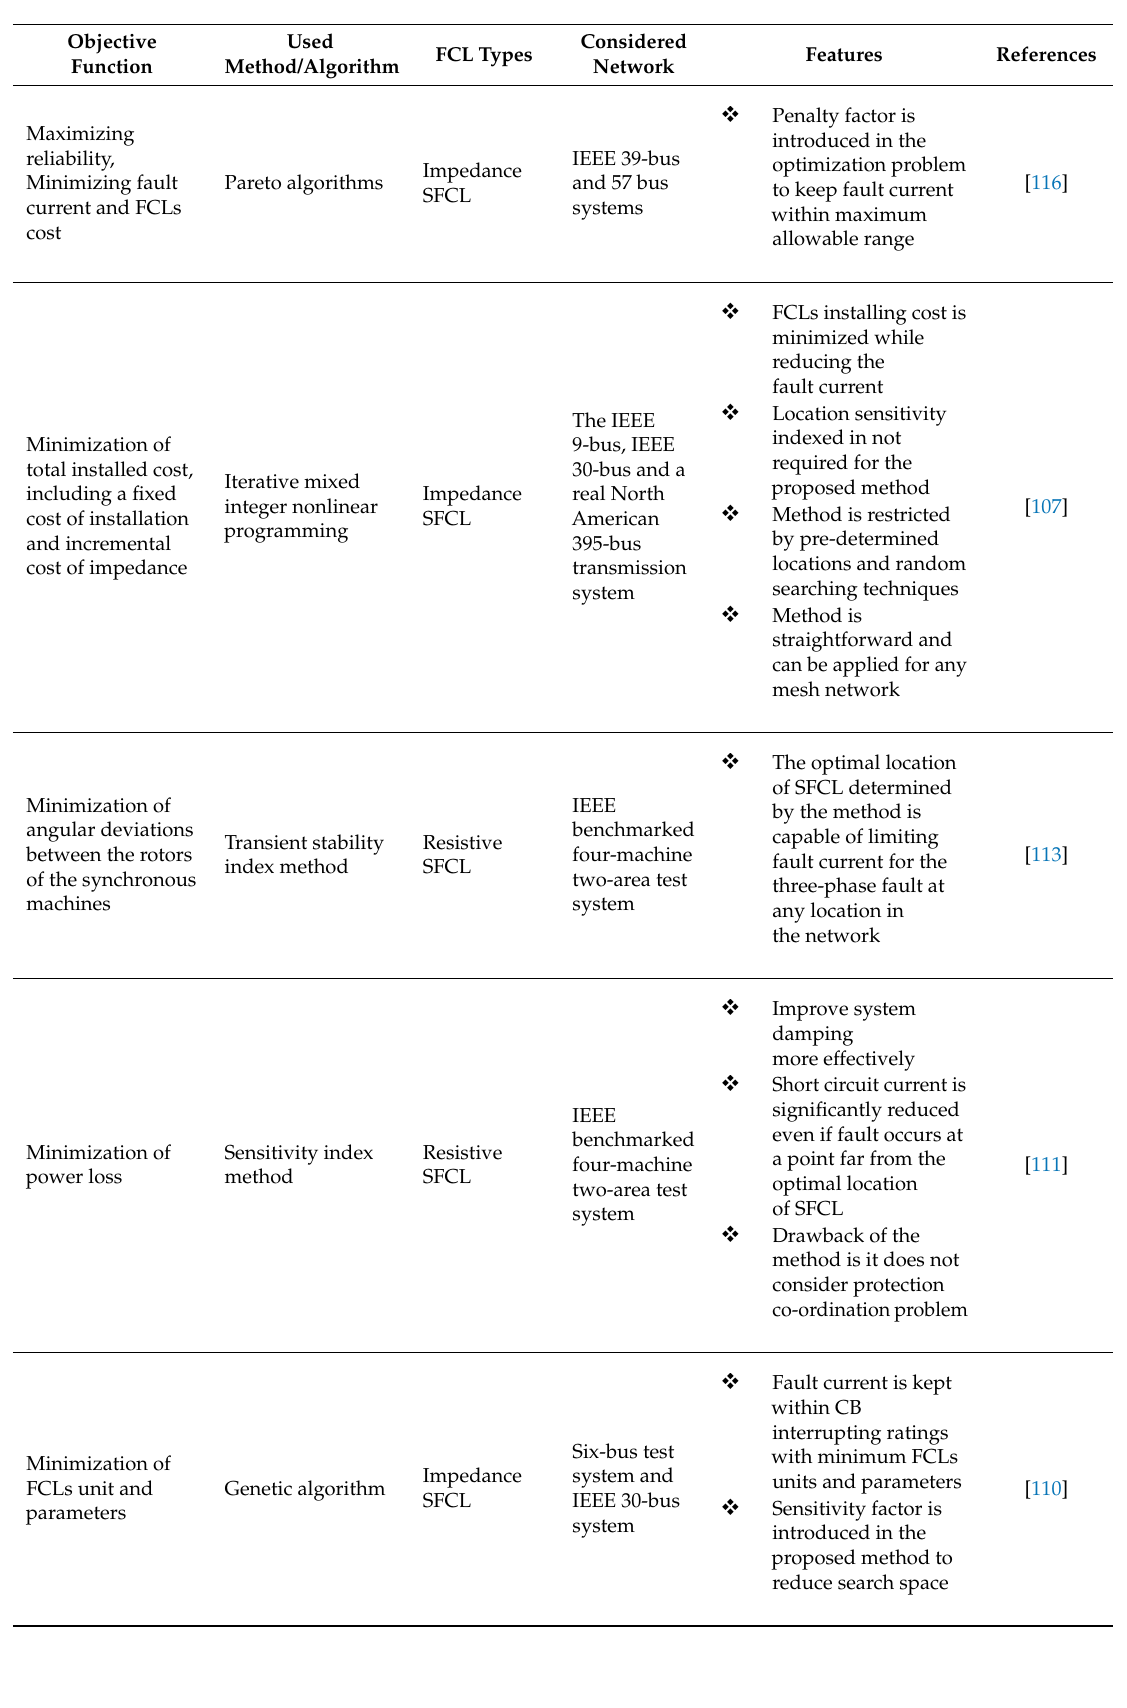
Figure 4. The phases for implementing a N-AHP in SWOT analysis.